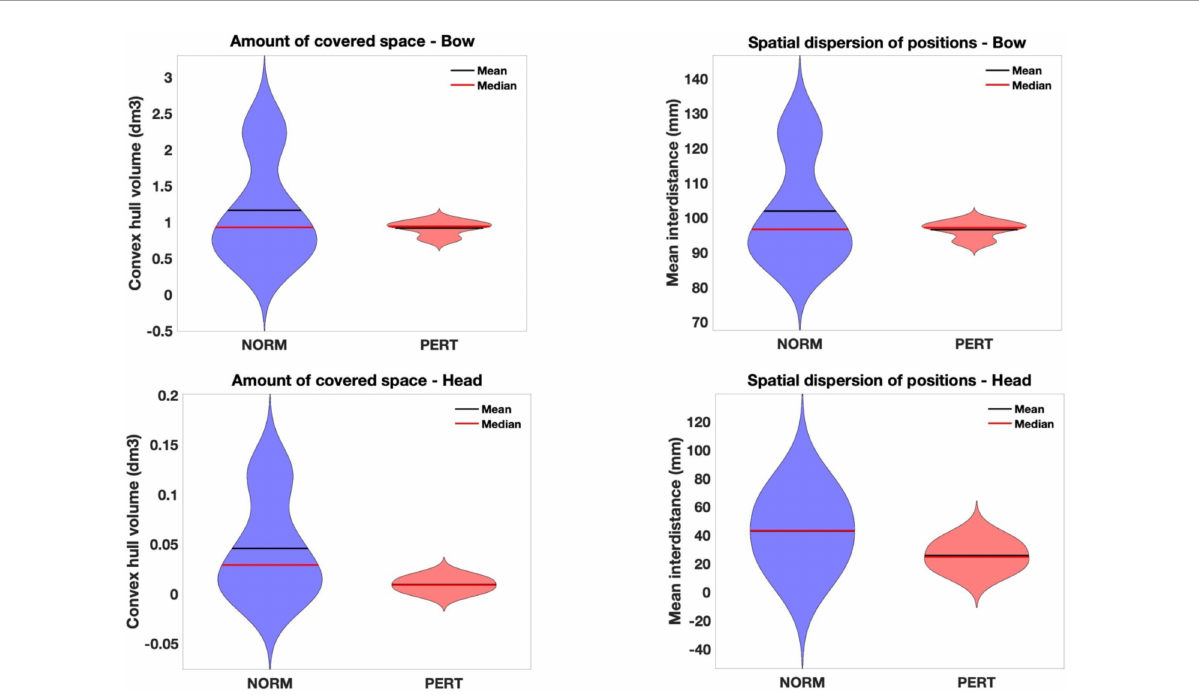
FIGURE4 Violin plots of the amount of covered space (convex hull volume – Left ) and spatial dispersion (mean inter-distance – Right ) of bow (Upper) and head (Lower) positions in each experimental condition. Head (but not bow) motion was drastically reduced in amplitude during perturbation. This partly explains the reduced variability in that condition, although it might also reflect more stable and shared movement strategies. In effect, while these variables didn’t differ in magnitude across conditions for the bow motion, variability among players was also drastically reduced during perturbation. Notice that the Y-scales for head and bow motion differ, because the possible range of head motion is physiologically restricted compared to the amplitude required by the execution of bow motion.